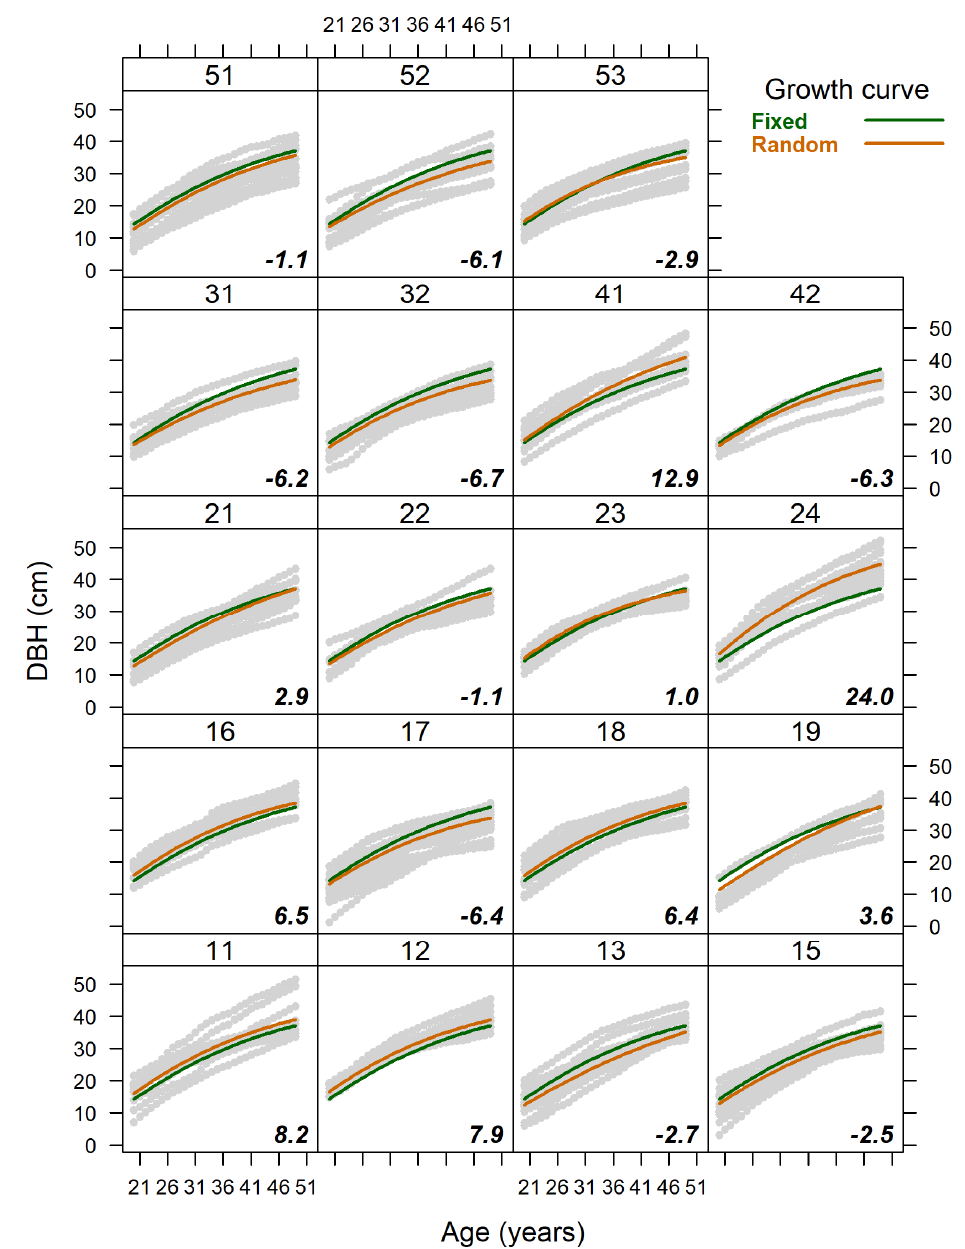
Figure 4. Predicted trajectories of DBH growth curves for population mean (fixed), each individual clone (random) and its realised genetic gain (numbers in bold and italic, %) at the final harvest age of 50 years (45 years of breast height age) using the final fitted model. Grey dots represent the sample data for each clone.